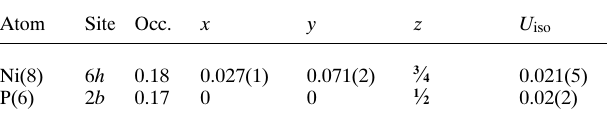
Table 2. Atomic coordinates and displacement parameters (in Å 2 ) . Table 1. Data collection and